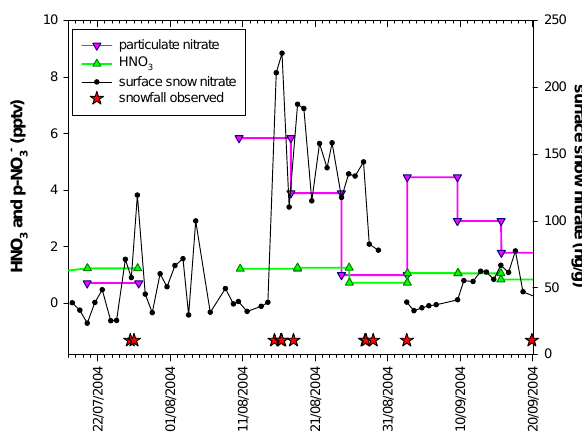
Fig. 5. The period in August when surface snow nitrate concentra- tions (black line) increased markedly. Also shown are atmospheric concentrations of HNO 3 and p-NO − . Also shown are snowfall ob- 3 servations which indicate either whether it was snowing at that time or whether it had snowed during the previous